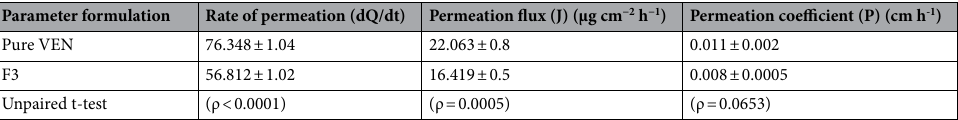
Table 3. Ex vivo permeation parameters of VEN solution and VEN-loaded PLA/PCL composite NFs (F3) through chicken cyst mucosa determined at 37 °C, data defined as average ± SD (n = 3). ρ value that represents the outcome of the unpaired t-test analysis (at the level of ρ < 0.05).